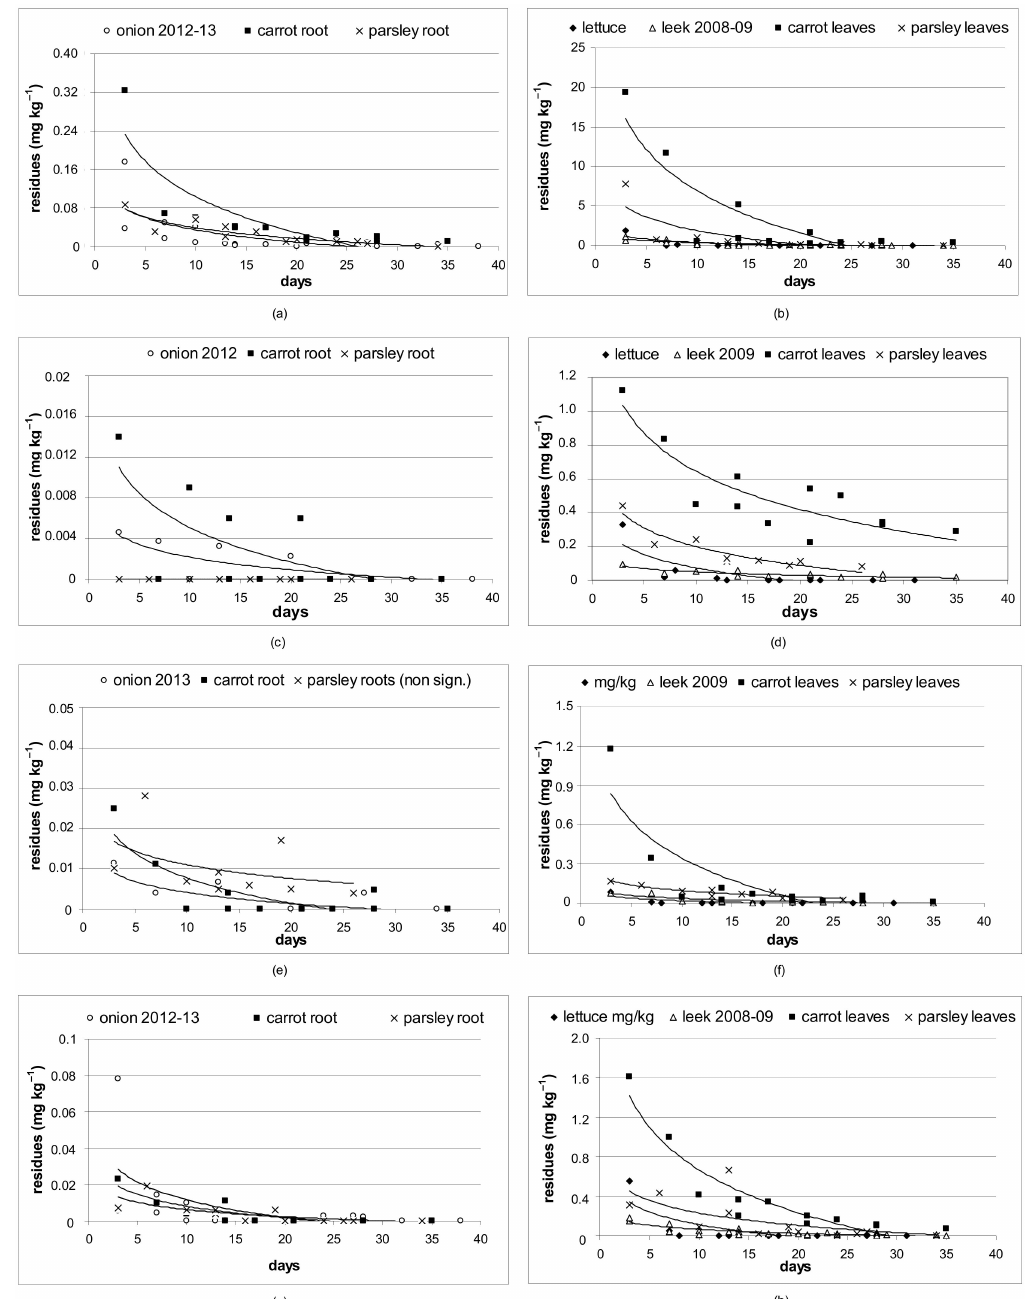
Figure 2. Dissipation of four active substances in vegetable species. ( a ) azoxystrobin on bulb and roots; ( b ) azoxystrobin on aboveground parts of crops; ( c ) cypermethrin on bulb and roots; ( d ) cypermethrin on aboveground parts of crops; ( e ) spinosad on bulb and roots; ( f ) spinosad on aboveground parts of crops; ( g ) thiacloprid on bulb and roots ( h ) thiacloprid on aboveground parts of